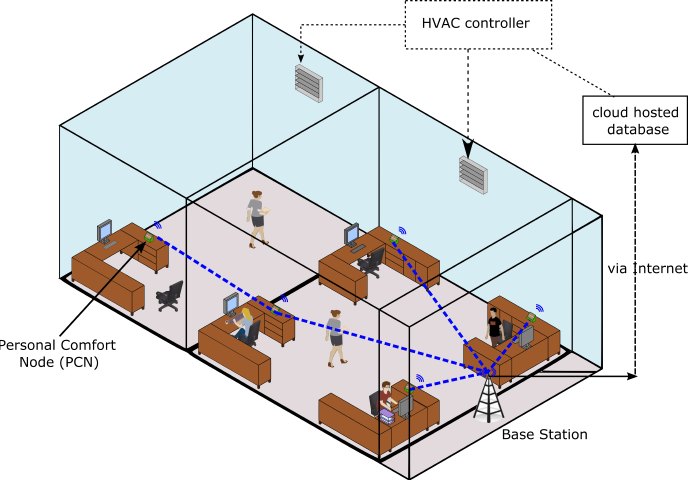
Figure 1. An overview of the PCIEM